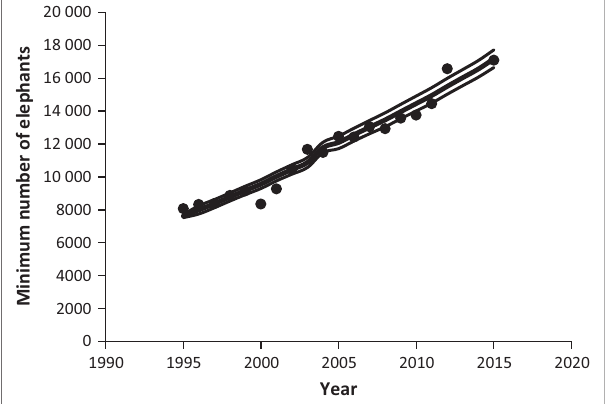
FIGURE 2: Minimum number of elephants living in the Kruger National Park since 1995 after intensive management of elephants stopped in 1994. We also illustrate the average model (line) and its 95 % confidence intervals (thin lines) since